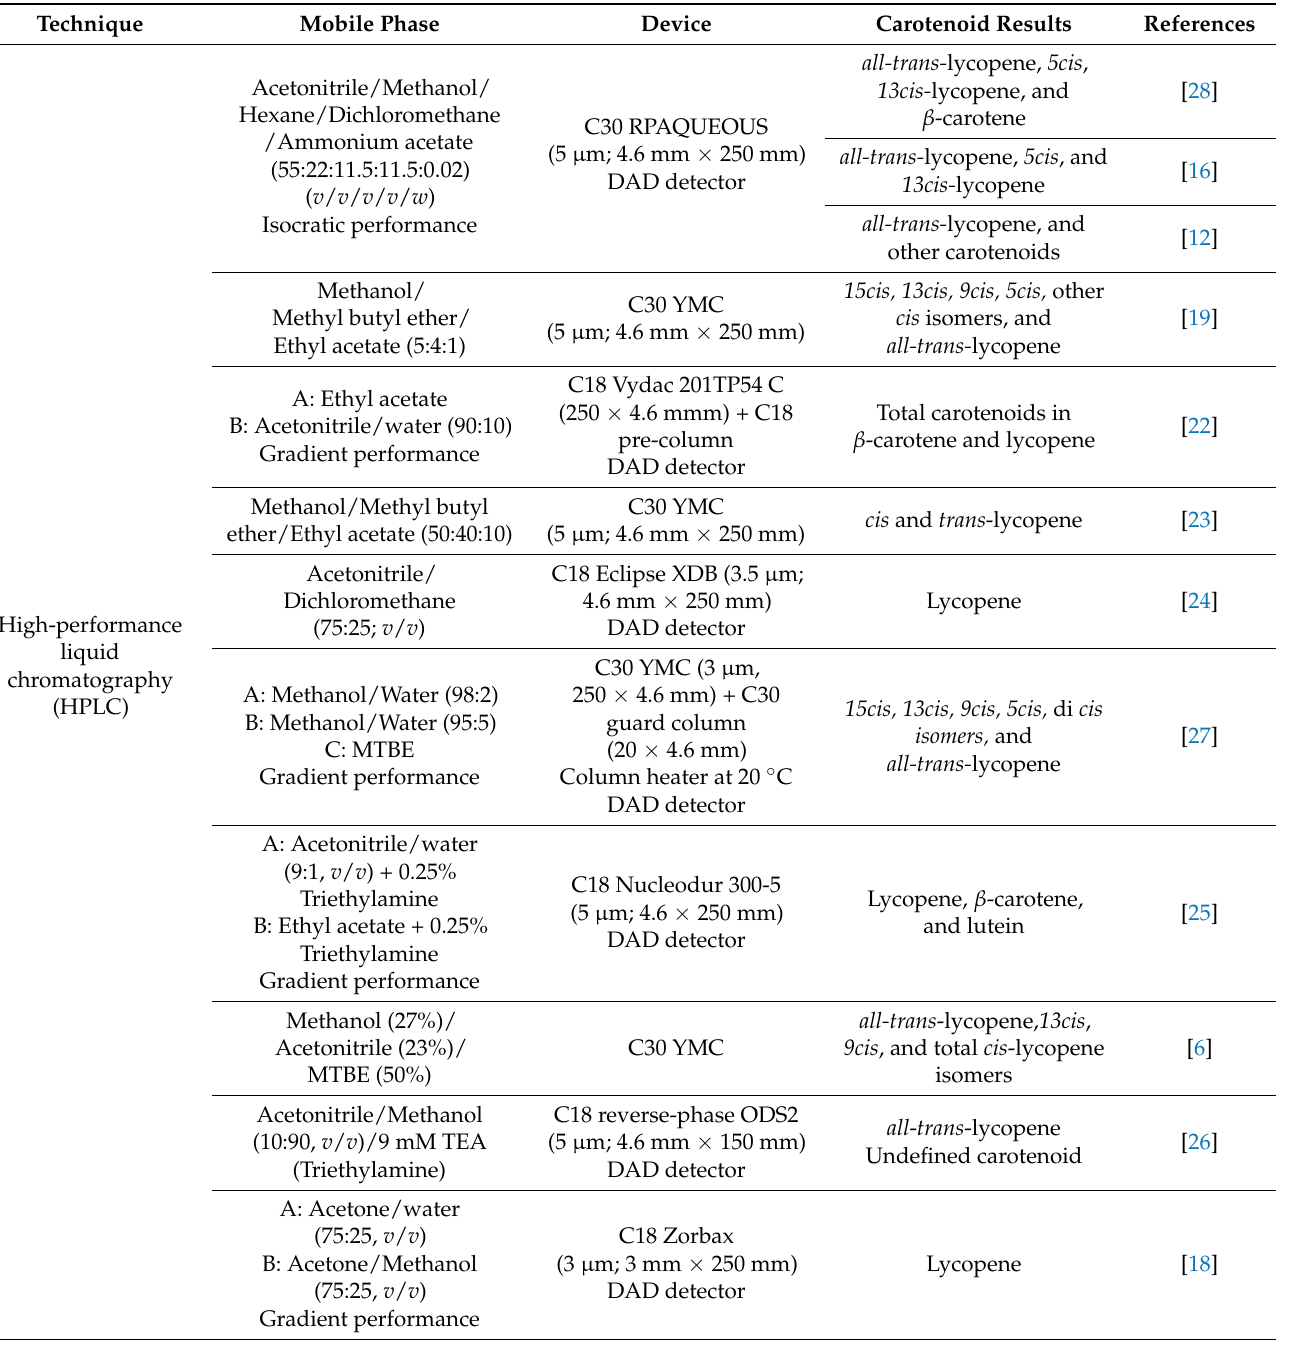
Table 2. Characterization and quantification methods for cis and trans -lycopene from 2017 to